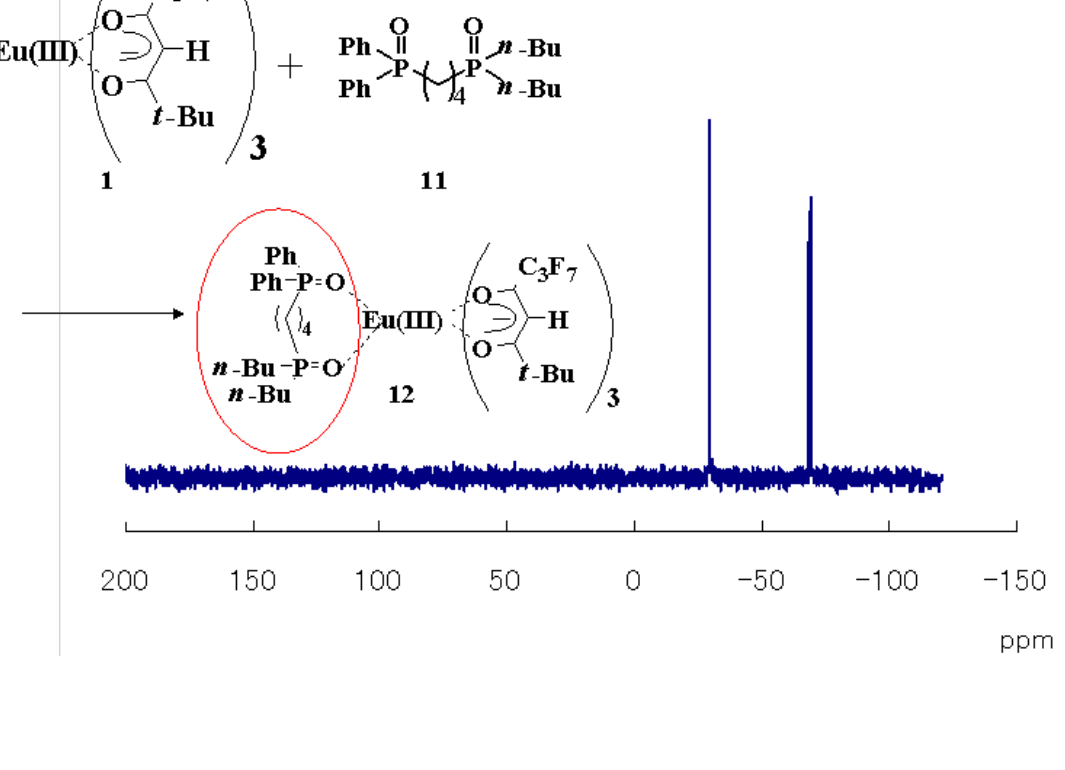
Figure 10. 31 P NMR spectrum of the mixture of Eu(III) complex 1 and non-symmetric bis- phosphine oxide 11